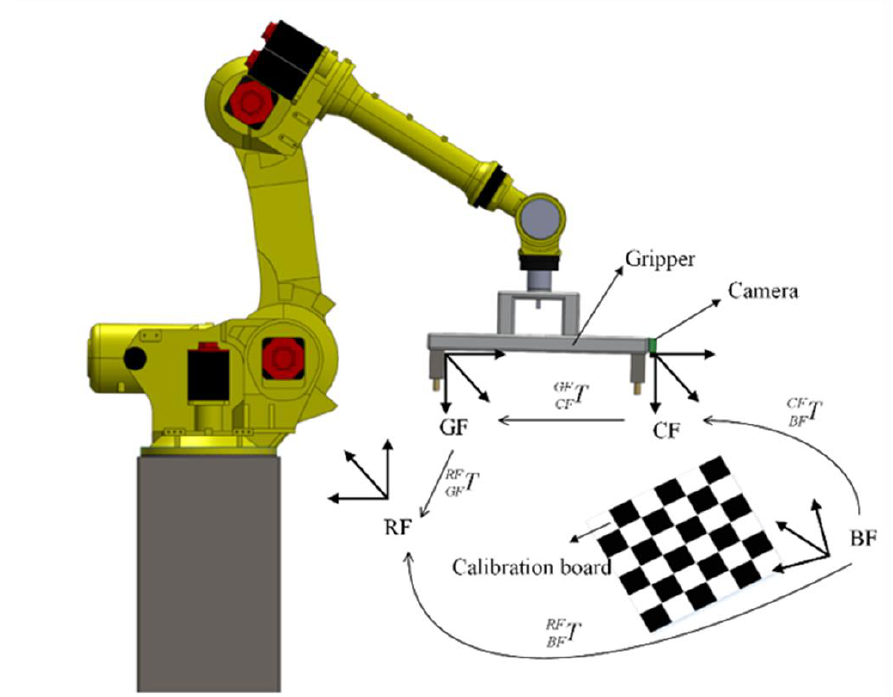
Figure 2. Hand-eye calibration is to determine the transformation relationship between CF and GF